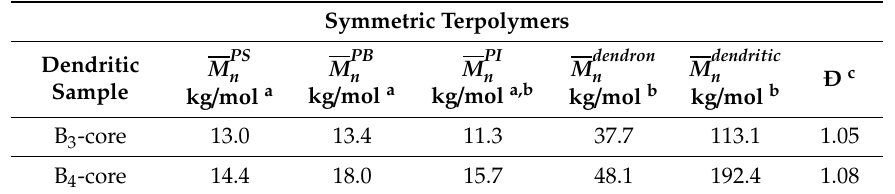
Table 1. Molecular characteristics of the symmetric dendritic terpolymers calculated by membrane osmometry / vapor pressure osmometry (MO / VPO) and size exclusion chromatography SEC.